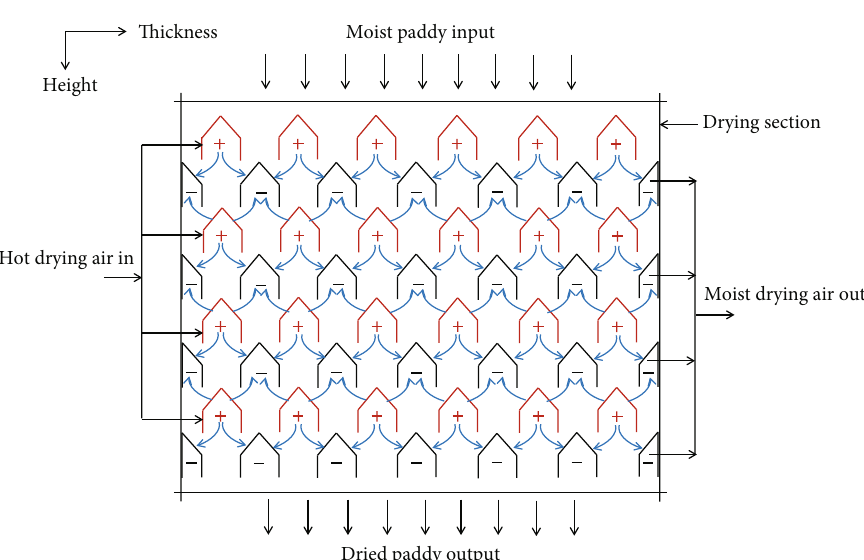
Figure 5: Air duct arrangement in the drying section (+ hot air inlet; – moist air outlet).